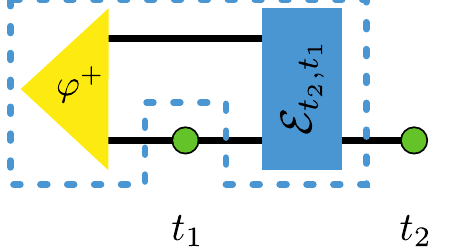
FIG. 13. Nonclassical process that does not display coherences. The state of the system is classical; i.e., it does not contain coherences with respect to the classical basis, at any step of the process. However, the corresponding statistics do not satisfy the Kolmogorov conditions. Potential measurements are depicted as green circles. The blue dotted line signifies the comb of the process (see Sec.